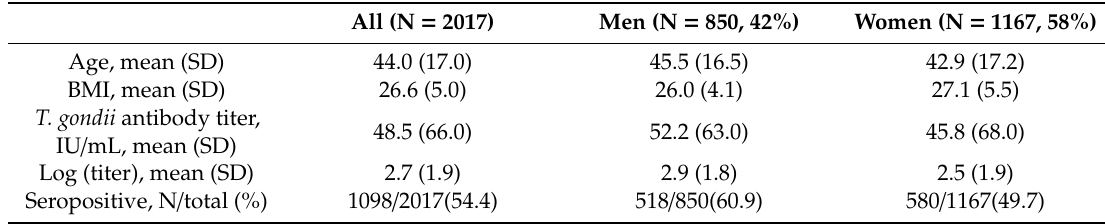
Table 1. Demographics and